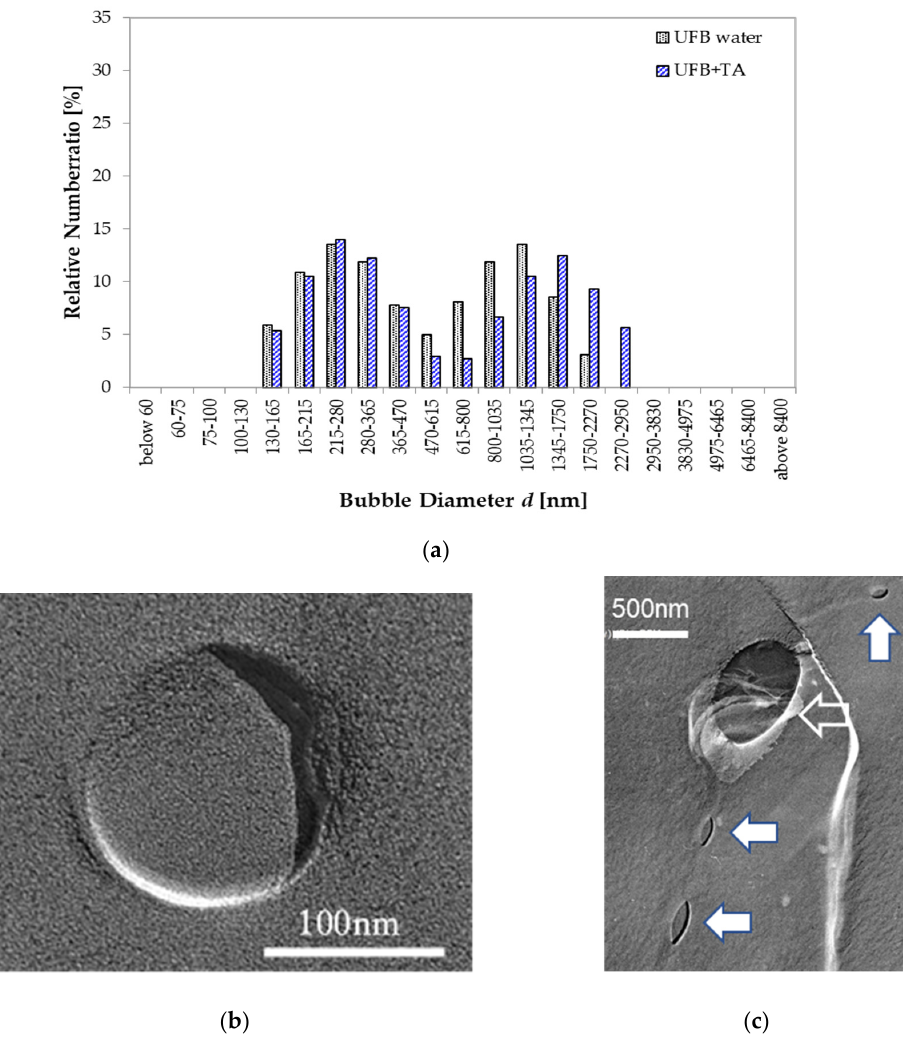
Figure 9. UFB sizes with TA. ( a ) Size distributions in pure water (gray solid) and in water with TA of 0.1 wt% (blue hatched). Ordinate scale is the fraction of UFBs per listed size range (both distributions add up to 100%). ( b ) TEM image of freeze-fracture replica of a UFB in the 0.1 wt% TA solution observed at high magnification. ( c ) Same as ( b ) except different UFBs and a lower magnification. Both smaller UFBs (solid allows) and a larger UFB (open allow) exist on an ice grain boundary. In contrast, when TC is added, the UFB distribution changes. Figure 10a shows the UFB size distribution changing from having twin peaks without the TC to having a single peak near a 300 nm diameter when the water has 0.1 wt% TC. Thus, by adding TC in the UFB-included water, the large UFBs apparently vanish, with only the small UFBs remain- ing.